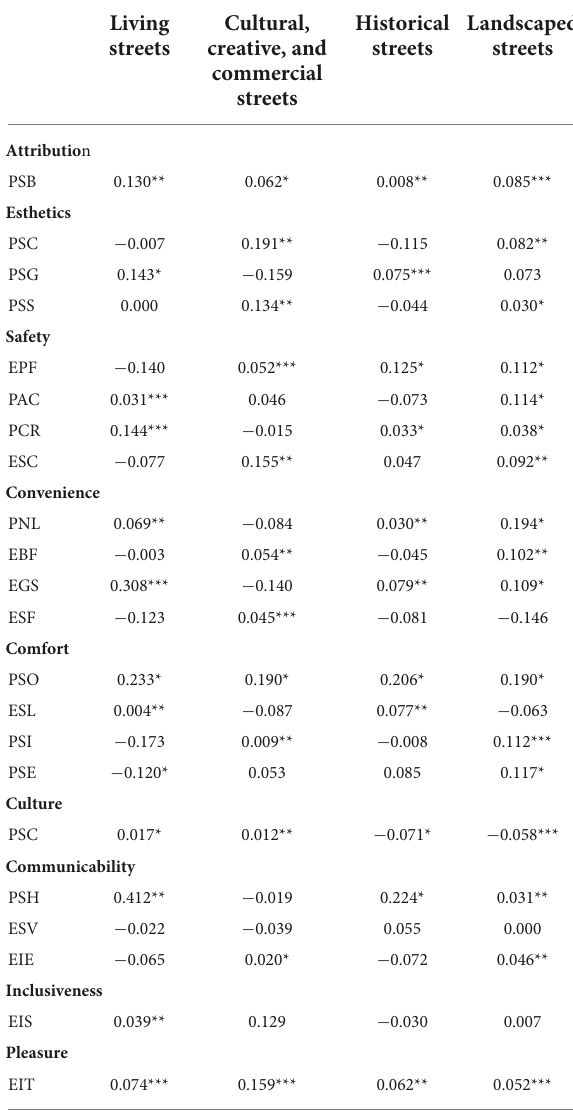
TABLE 3 Correlation coefficients for street usage and psychological